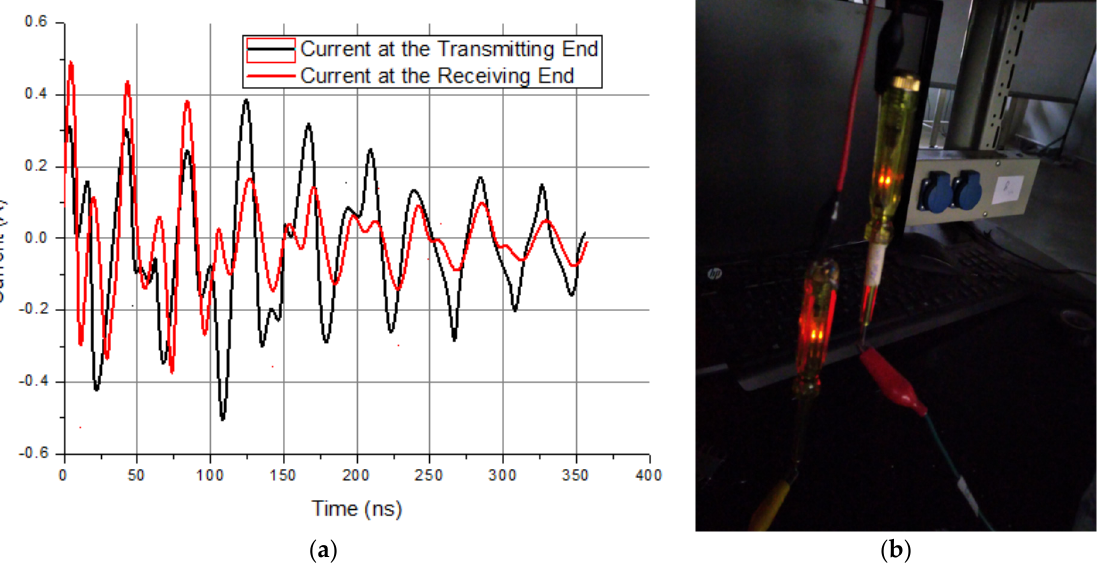
Figure 3. Results of the basic functionality test. ( a ) Waveforms of the currents harvested at the trans- mitting end and the receiving end. ( b ) Photo showing how the surface power was received by mul- tiple loads.